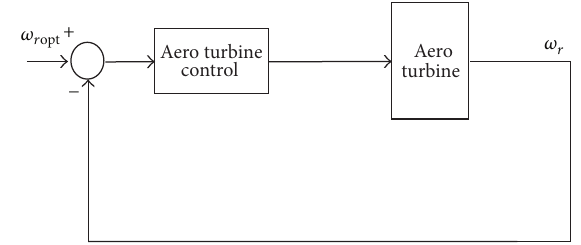
Figure 2: WT control